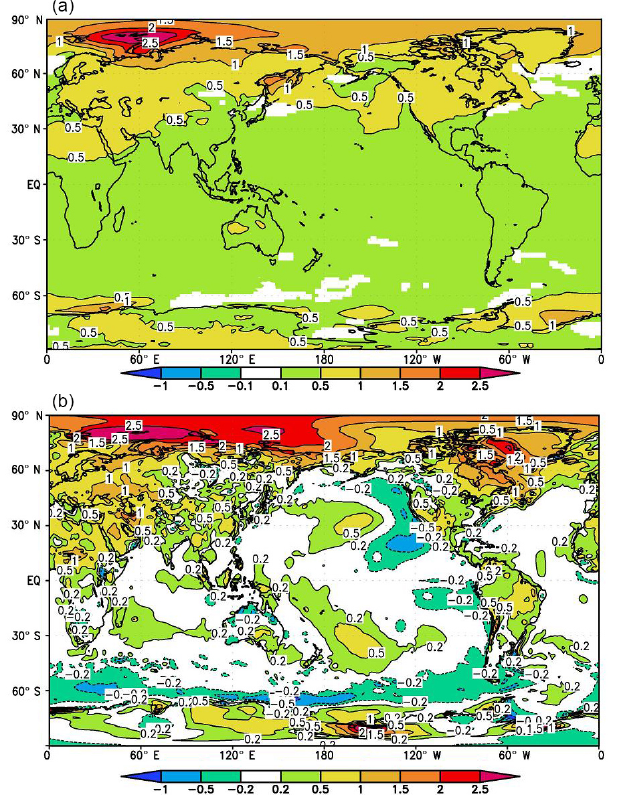
Figure 9. Annual mean near-surface air temperature (K) in 2000– 2014 minus 1985–1999 for model mean data (a) ; shading represents the 99% level of significance; ERA-Interim data (b)